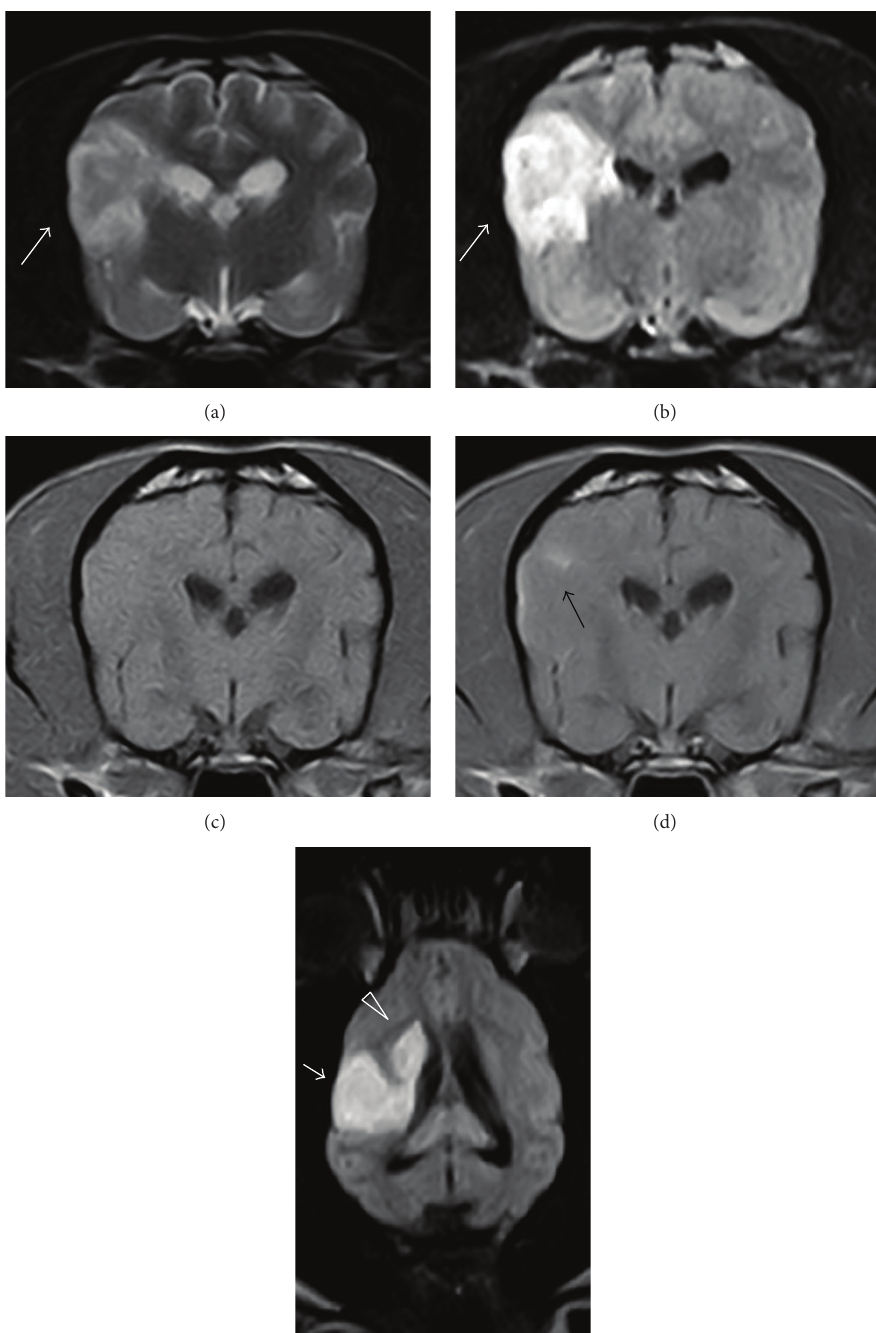
Figure 1: Magnetic resonance images of the brain. Transverse T2-weighted (a), FLAIR (b), T1-weighted (c), and T1-weighted, after IV gadolinium administration, (d) images at level of the thalamus; (e) dorsal FLAIR image at level of the dorsal part of the lateral ventricles. There are extensive focal grey and white matter T2 and FLAIR hyperintensity in the right temporal lobe without mass effect (white arrows). The lesion appears isointense to the normal gray matter (c) with mild contrast enhancement (black arrow) (d). The signal changes are most marked within the cortical gray matter (a). On dorsal plane the lesion extends to the right caudate nucleus (arrowhead) (e). Based on MRI features and distribution, the lesion appeared compatible with ischemic infarct in the territory of the right middle cerebral artery and its striate